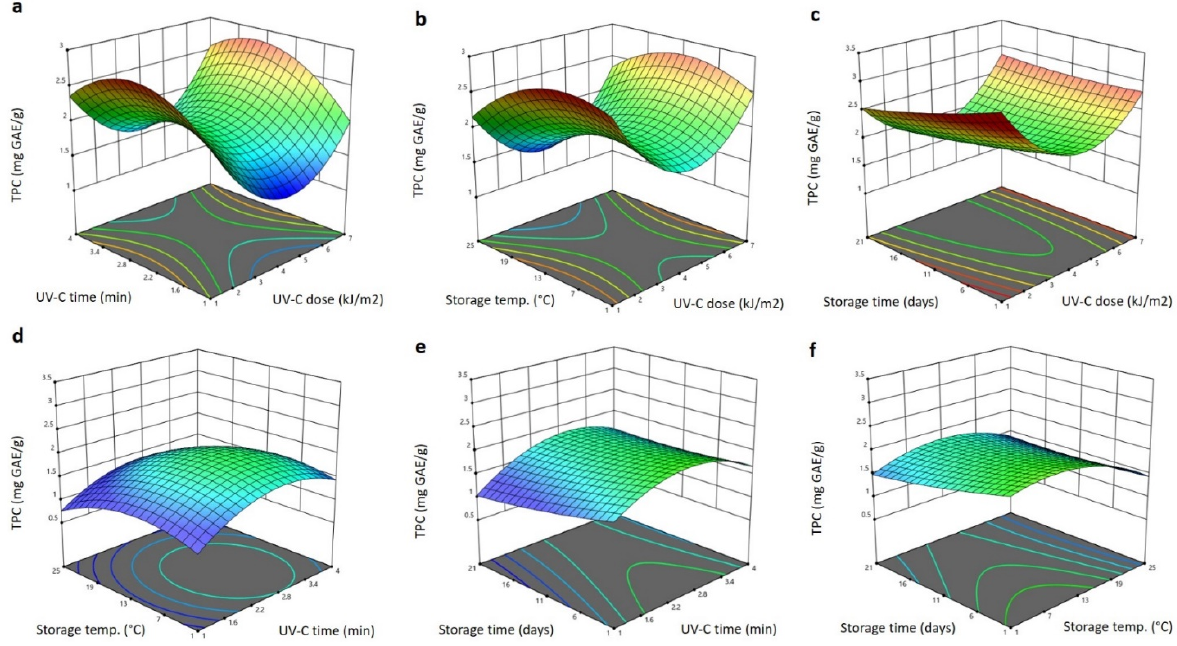
Figure 6. Response surface plots of total phenolic content (TPC) of Barhi dates as a function of UV-C time and UV-C dose ( a ), storage temperature and UV-C dose ( b ), storage time and UV-C dose ( c ), storage temperature and UV-C time ( d ), storage time and UV-C time ( e ), and storage time and storage temperature ( f ).